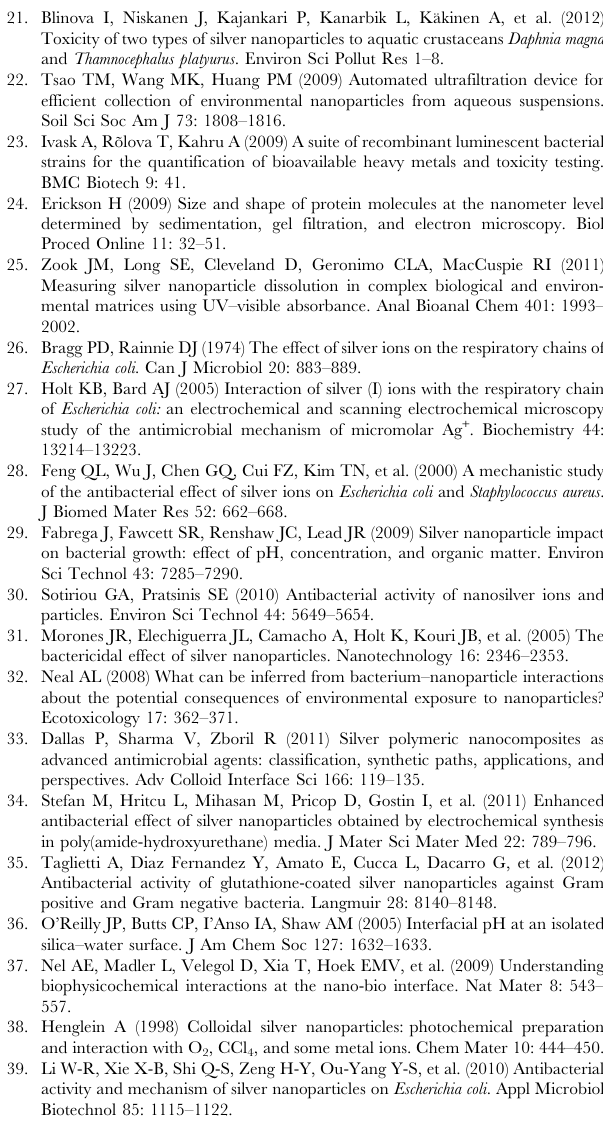
Table S1 Characteristics of the bacterial strains used in this study. Table S2 Minimum bactericidal concentration (MBC mg Ag/l) of silver nanoparticles and AgNO 3 to six bacterial strains. nAg states for uncoated AgNPs, nAg-PVP for PVP-coated AgNPs and nAg-Col for collargol. Bacteria were incubated with different concentrations of Ag-compounds in half- strength NaCl-free LB medium at 30 u C for 4 h. Then, 3 m l of the test sample was pipetted onto agarized LB plates, incubated at 30 u C for 24 h and visually inspected for the growth. The lowest tested concentration that completely inhibited the visible growth of bacteria was designated as a MBC.